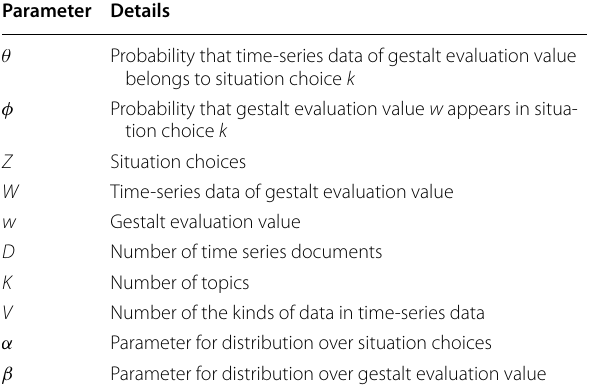
Table 4 Parameters used in LDA topic